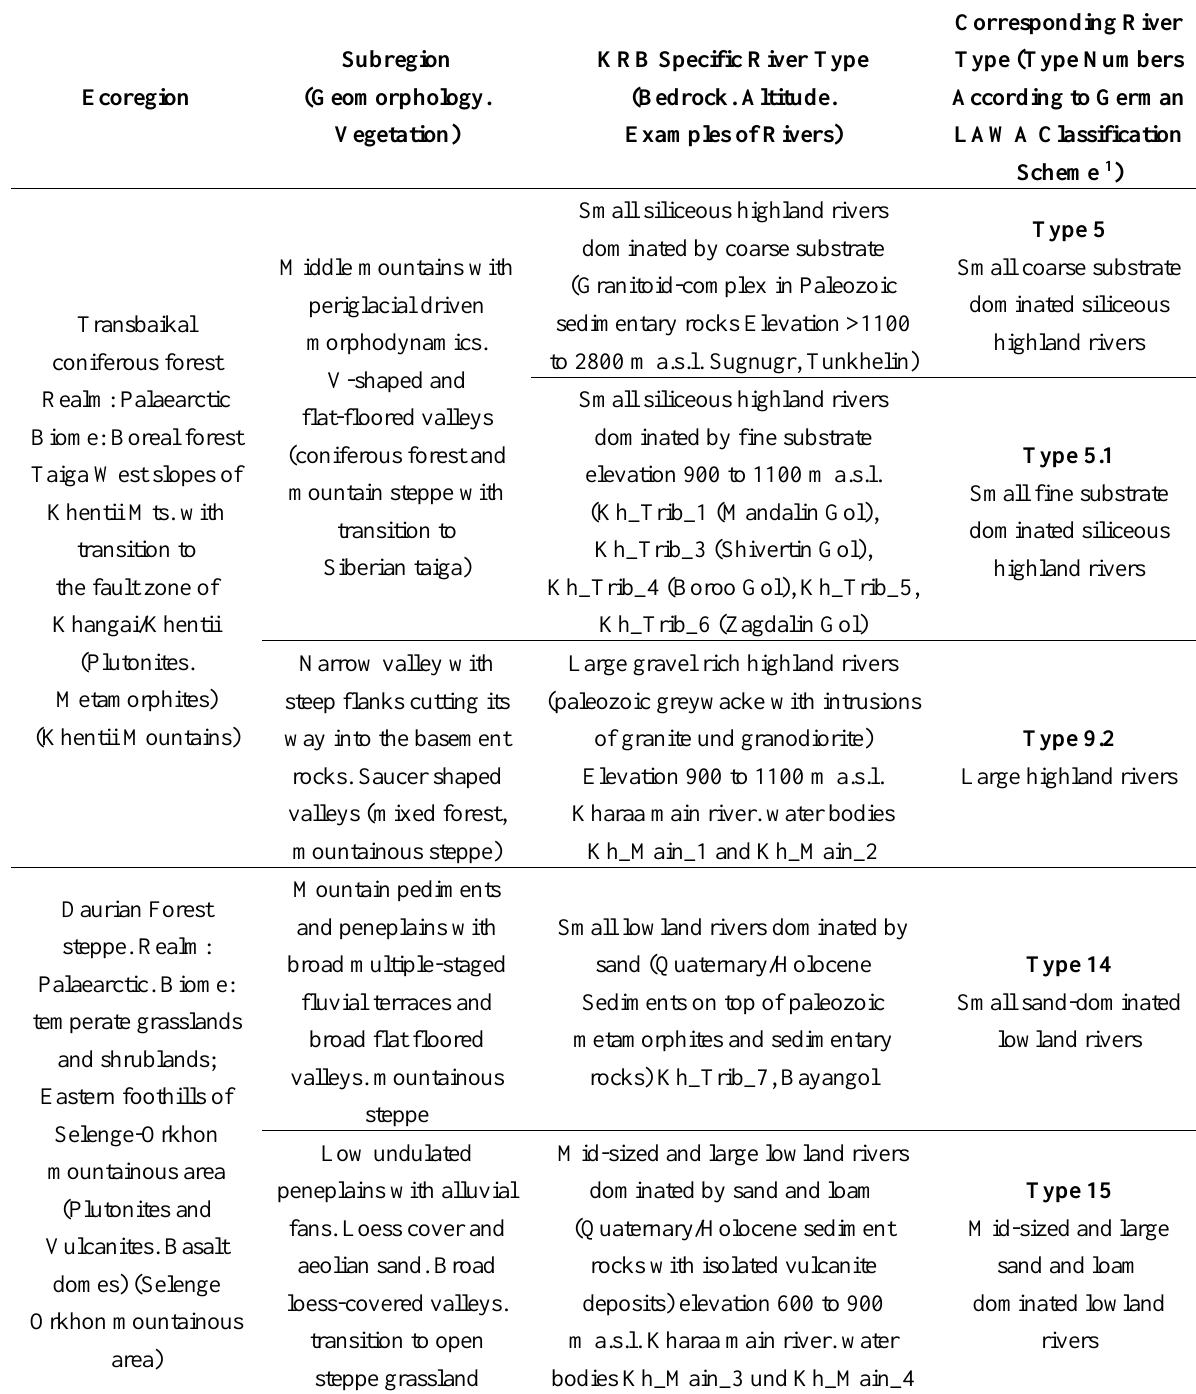
Table 4. Description of specific river types in KRB, their eco- and sub- regions and corresponding river types and type numbers according to German LAWA classification [51,52